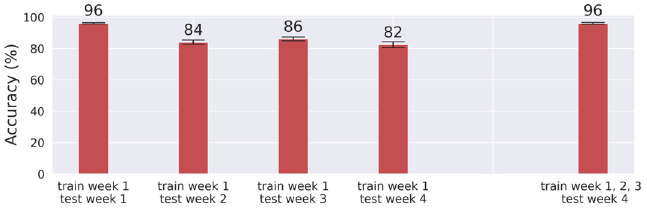
Figure 3. Cross-week personal identification. The means of 10-person identification accuracies and their standard errors resulted from single-day (the four bars on the left) and multi-day EEG data (the rightmost